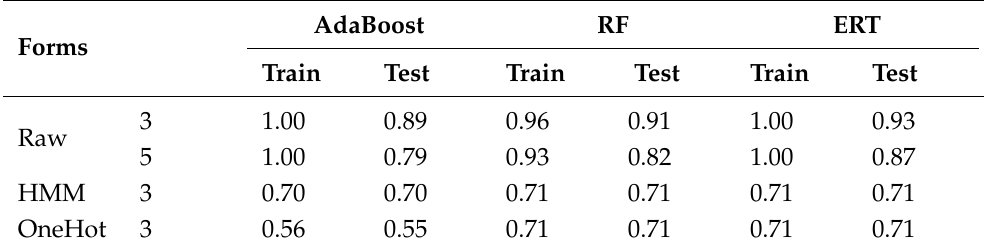
Table 8. The A cc of models for the torque prediction in different forms of input variables.